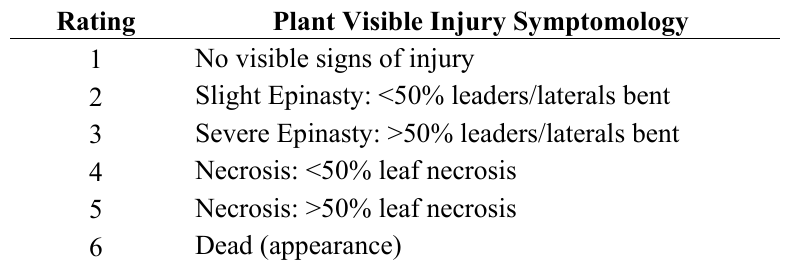
Table 3. Injury rating scale for evaluation of greenhouse seedling and germinal